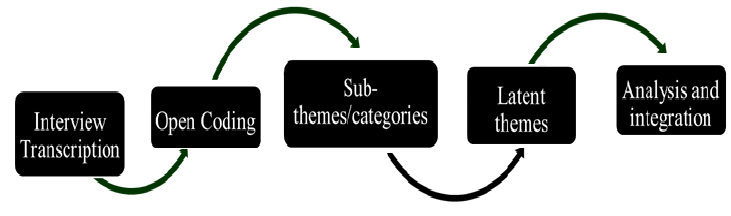
Figure 1: Schematic Illustration of Data Analysis